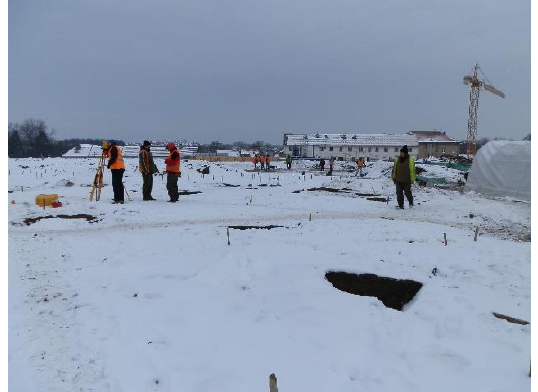
Figure 5. Dolní Břežany (Central Bohemia). Rescue archaeological excavation on the construction site of the HILASE project.